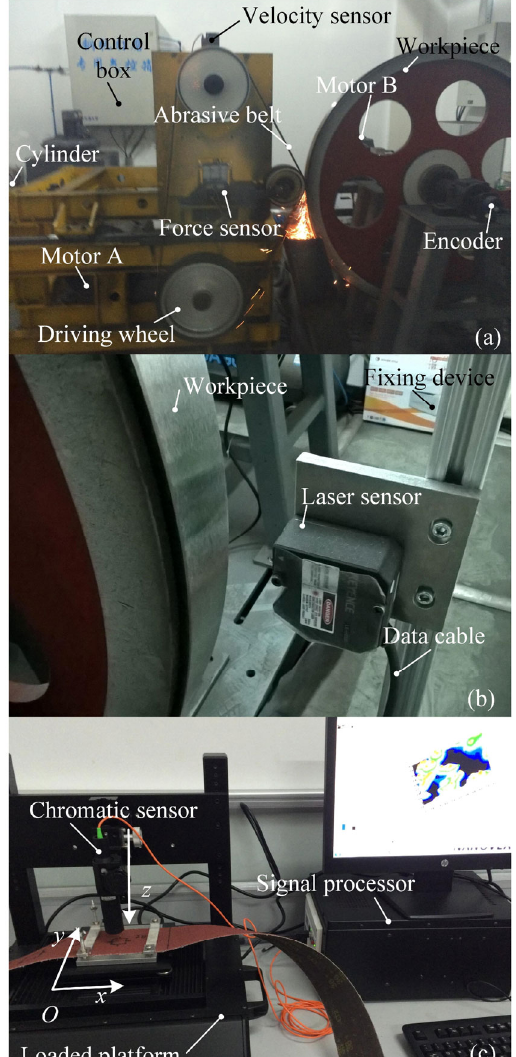
Fig. 8 Devices for grinding experiments: (a) grinding apparatus, (b) laser sensor, and (c) optical